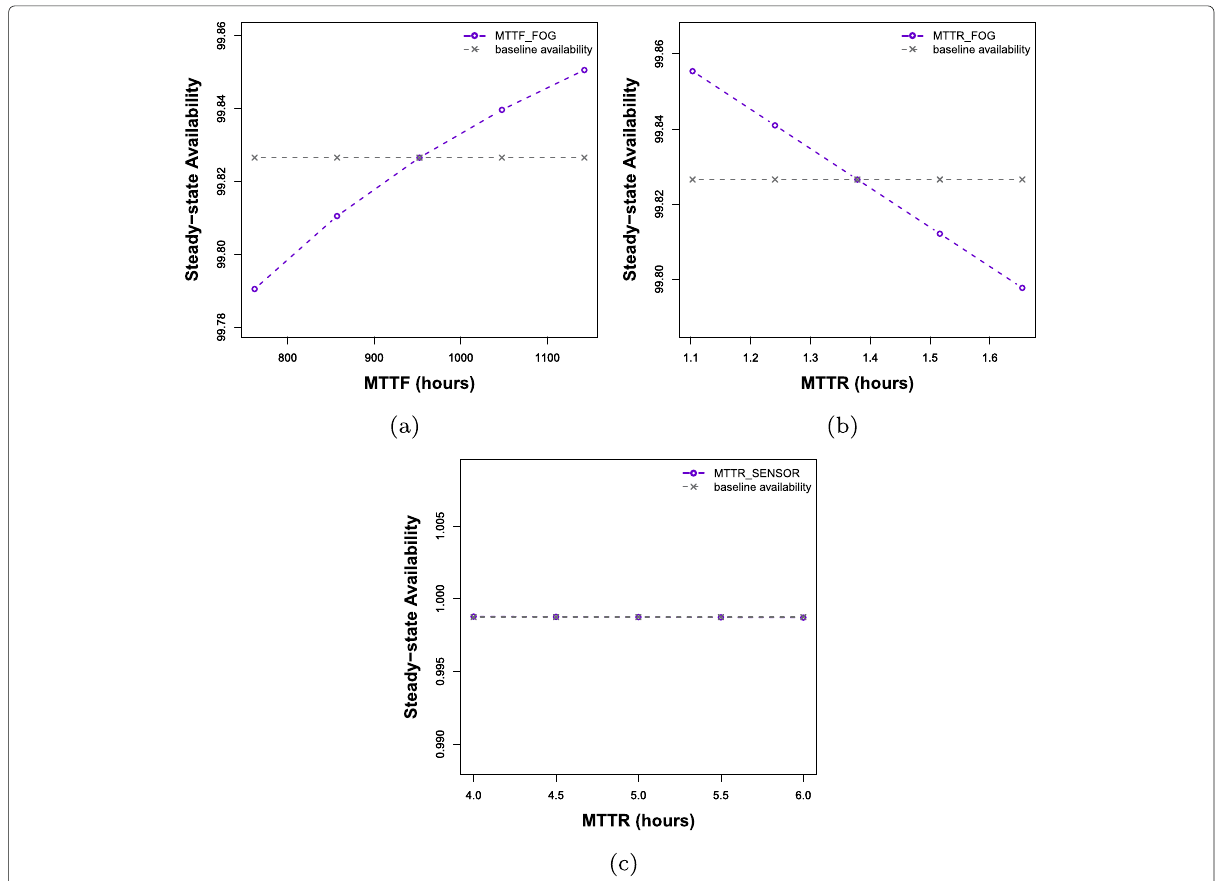
Fig. 16 Availability results of scenario 3 varying a the fog MTTF, b the fog MTTR and c , the sensor MTTR